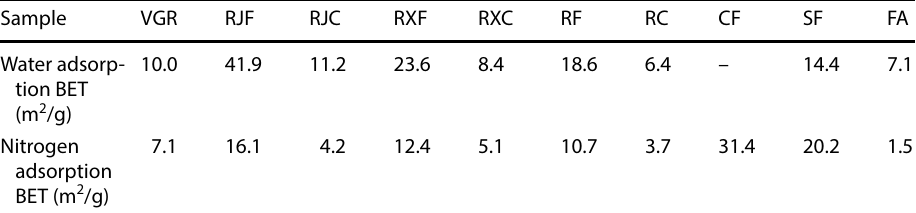
Table 6 BET surface area determined from water and nitrogen